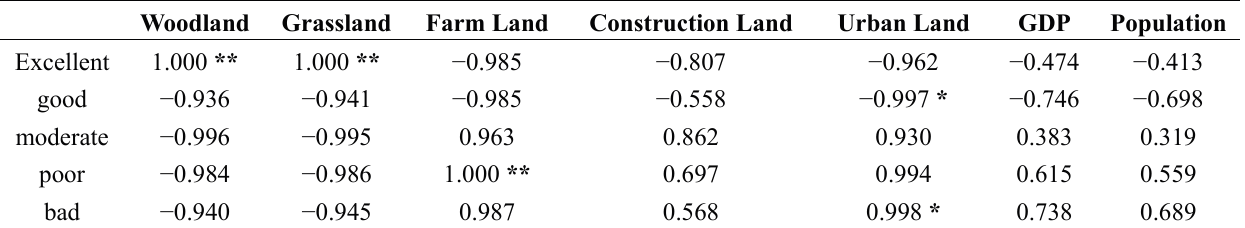
Figure 5. Distribution of land use types and reservoirs and sluices in HRB. Table 4. Correlation analysis of RHQ scores with several